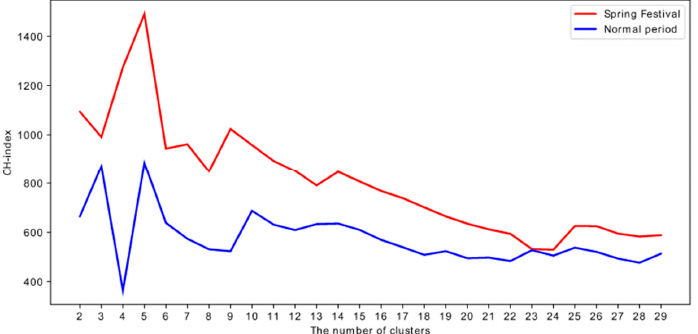
Figure 4. The relation between the number of clusters and the Calinski–Harabasz Index Figure 4. Relation The relation between the number of clusters and the Calinski–Harabasz Index (CH-index).